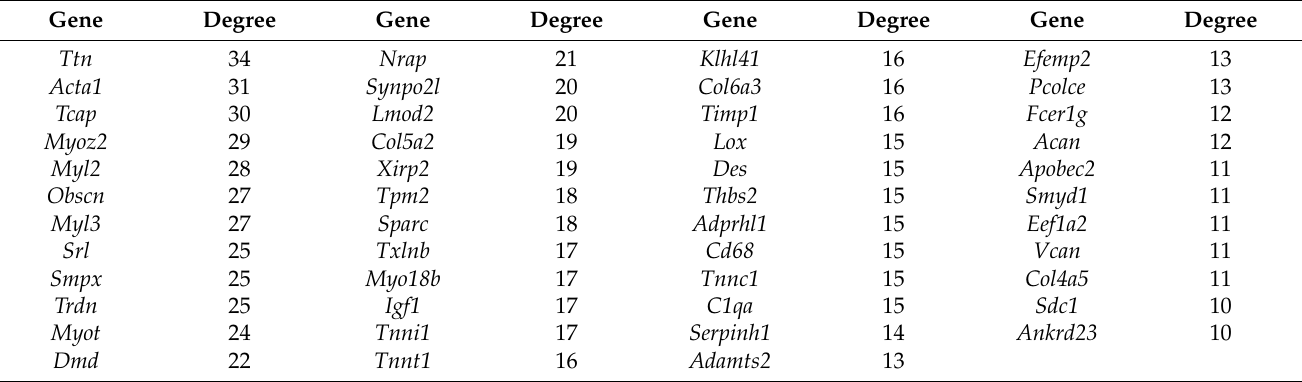
Figure 5. Protein–protein interaction (PPI) analysis. PPI network for all the overlapping DEGs is constructed and followed by module analysis using the MCODE plugin on the Cytoscape (V.3.9.0) platform. Modules with a blue border are significant modules. The size of circles reflects the degree of connectivity. Table 5. List of hub genes and connectivity degree.